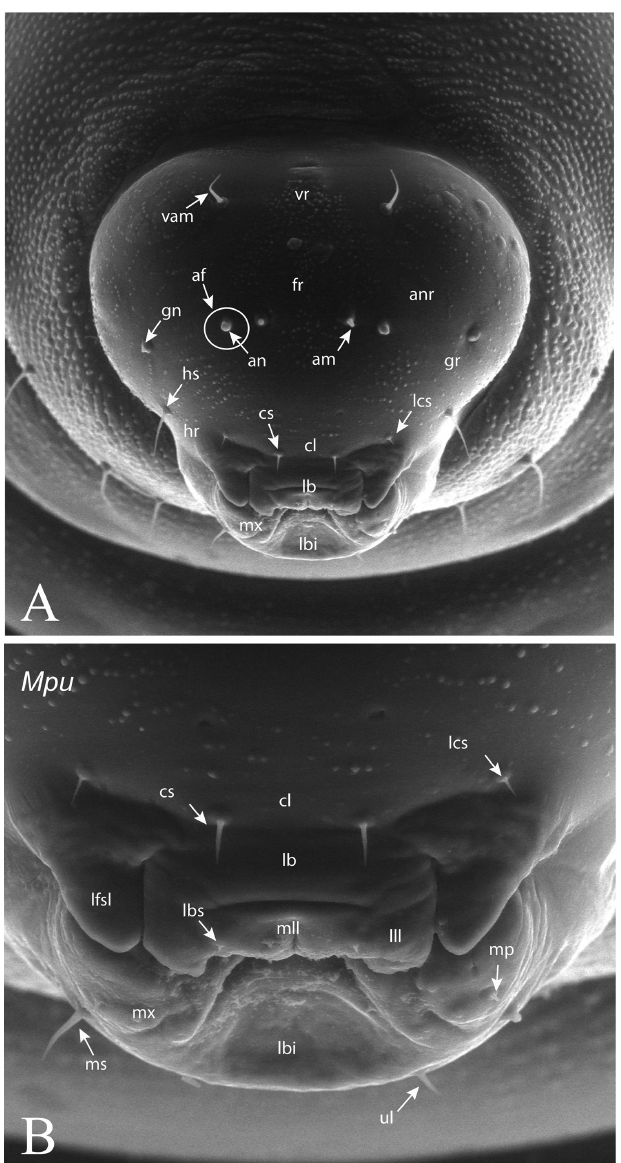
Figure 2. Ormyrus nitidulus . A Anterior view of head illustrating terminology used for general descrip- tion (see text). Abbreviations: af , antennal foramina; am , antero-medial setae on the antennal region; an , antenna; anr , antennal area; cl , clypeus; cs , clypeal seate; fr , frons; gn , genal setae; gr , genal region; hr , hypostomal region; hs , hypostomal setae; lb , labrum; lcs , lateral clypeal setae; vam , antero-medial setae of vertex; vr , vertex region B Anterior view of mouthparts. Abbreviations: clypeus ( cl ); clypeal setae ( cs ); labrum ( lb ); lateral flaps of sides of labrum ( lfsl ); lateral lobe of labrum ( lll ); lateral clypeal setae ( lcs ); labral setae ( lbs ); medial lobe of labrum ( mll ). The under-lip complex ( Mpu ) is formed by labium ( lbi ) and maxillae ( mx ); maxillary palps ( mp ); Mpu setae: maxillary setae ( ms ) and antero-medial labial setae ( ul